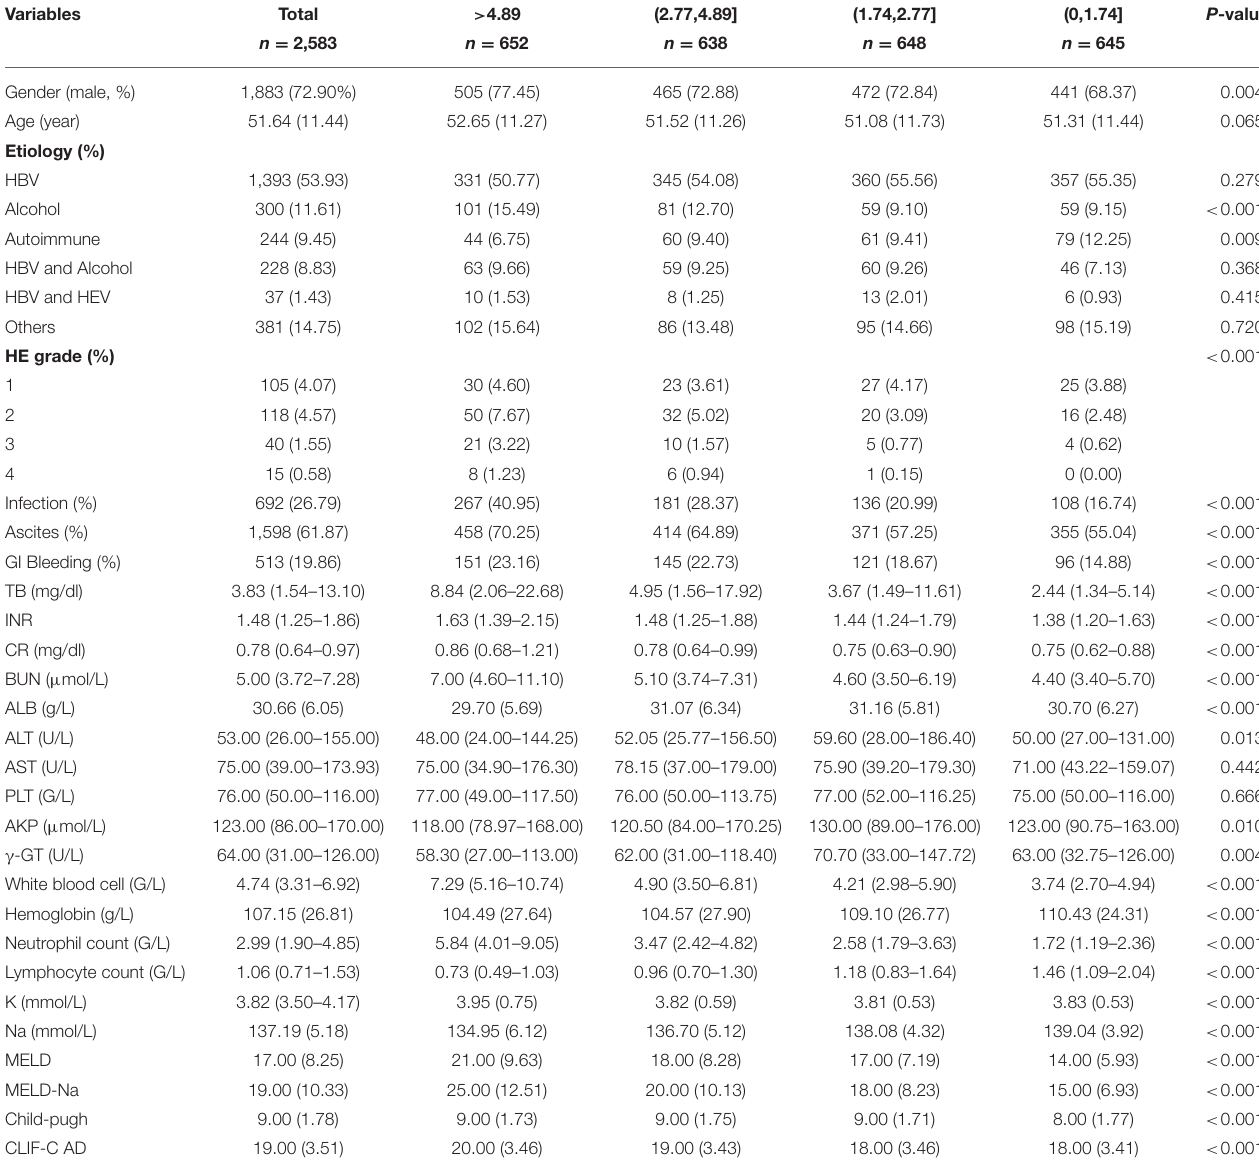
TABLE 1 | Baseline characteristics in all